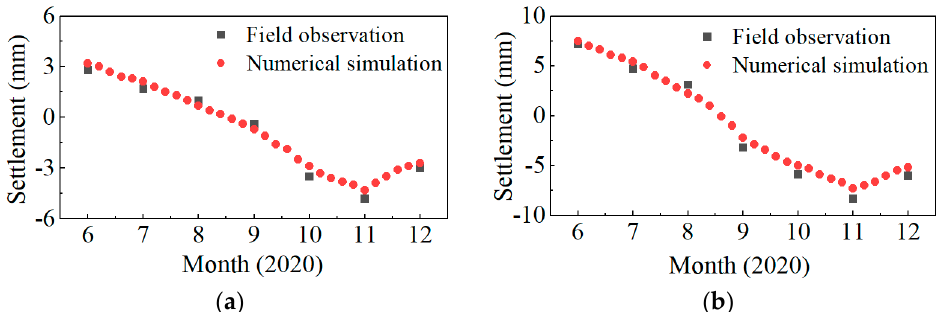
Figure 10. Comparation between numerical results and fi eld observation results: ( a ) at the center of the subgrade; ( b ) at the left slope toe of the subgrade. the subgrade; ( b ) at the left slope toe of the